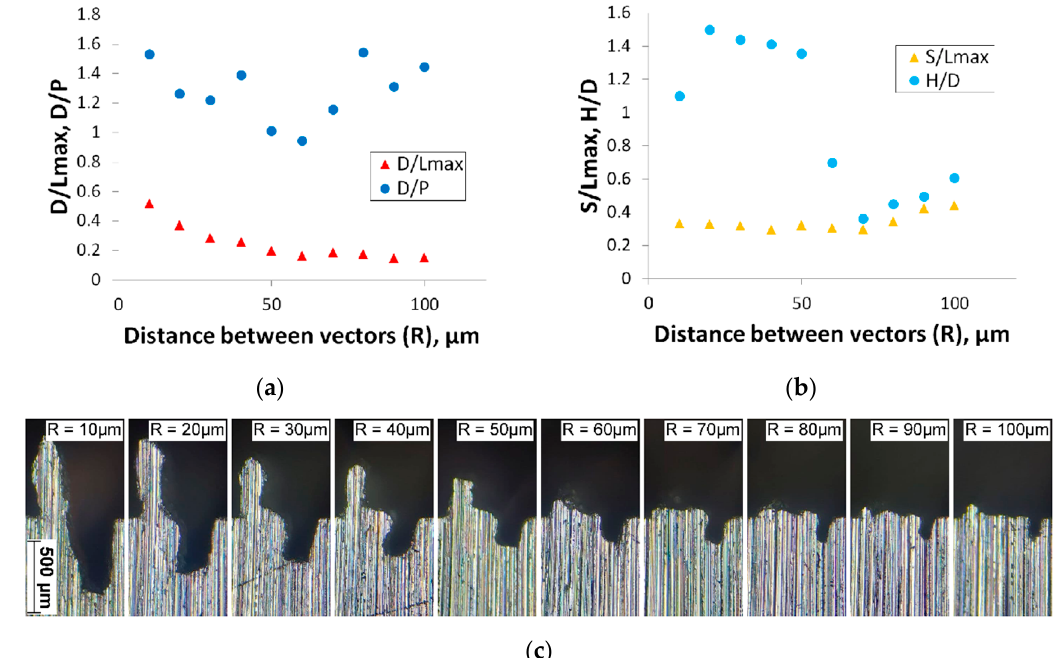
Figure 4. Graphs of the dependences of the investigated parameters ( a ) D, P and ( b ) S, H on the distance between the vectors ( R ), as well as ( c ) the transverse sections of the grooves obtained at different values of R (10–100 µm).